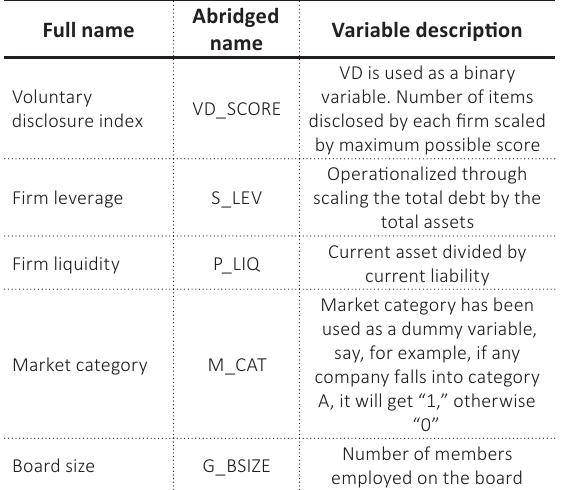
Table 1. Operationalization of variables used